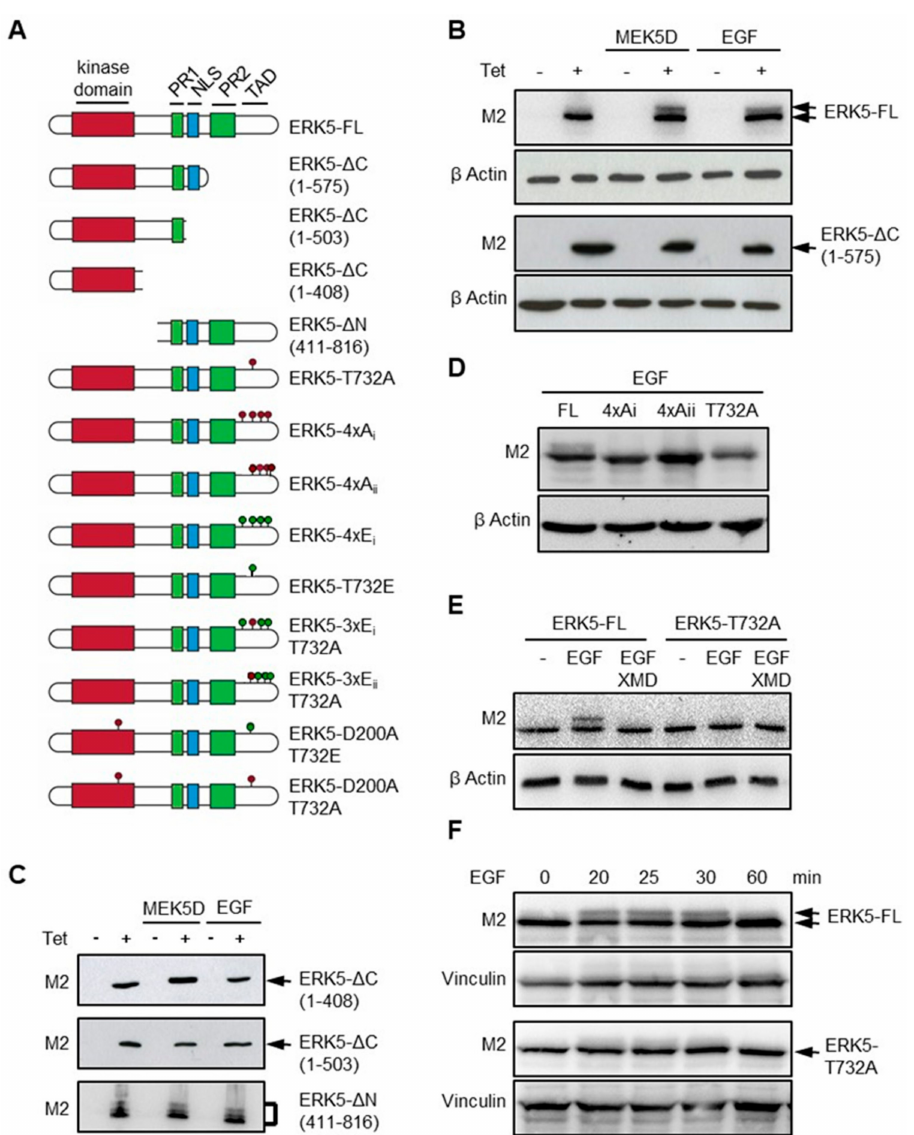
Figure 1. Extracellular signal-regulated protein kinase 5 (ERK5) phosphorylation at Thr 732 is a pre-requisite for C-terminal phosphorylation. ( A ) A schematic illustration and nomenclature of ERK5-FL, truncated N-terminal (ERK5- ∆ N) and C-terminal (ERK5- ∆ C) mutants, and various mutants in which specific serine and / or threonine residues were replaced by alanines or glutamic acids. ( B–F ) Recombinant Flp-In HeLa cells were incubated with Tet ( + ) for 24 h. Mock treated cells with DMSO ( − ) were used as controls. Where indicated, the cells were transfected with a construct encoding HA-tagged MEK5D 24 h before Tet induction, or stimulated for 25 min, unless indicated otherwise (panel F), with EGF (20 ng / mL) before harvesting. In panel E, cells were pre-incubated with XMD8-92 (5 µ M) for 1 h prior to epidermal growth factor (EGF) stimulation. Cell lysates were analyzed by immunoblot using a specific antibody to the Flag-tagged epitope (M2). Antibodies to β actin or vinculin were used to monitor protein